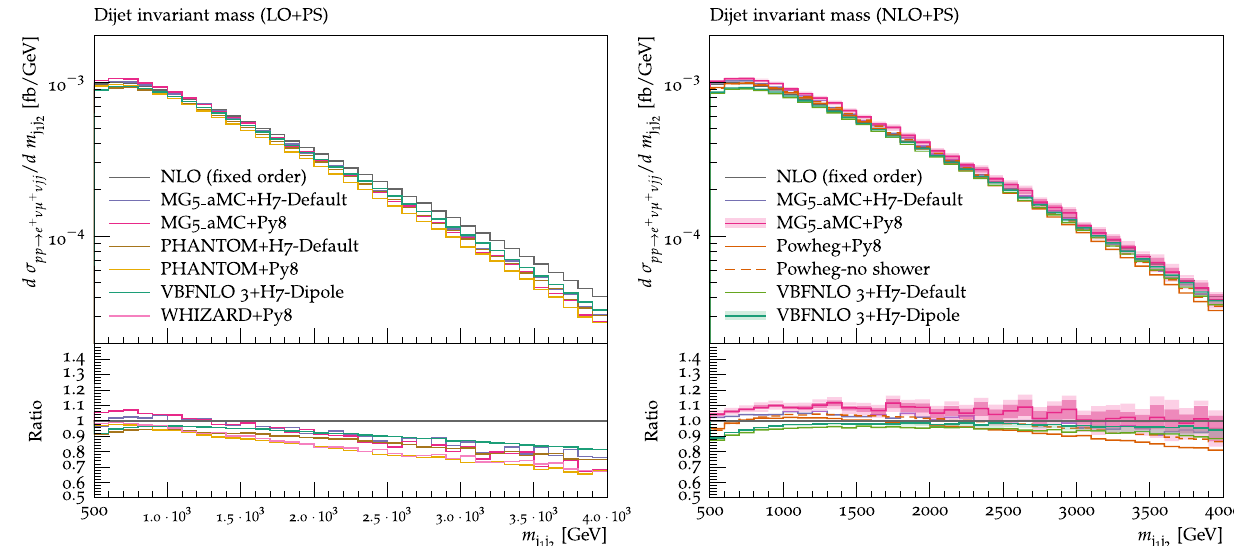
Fig. 14 Differential distribution in the invariant mass of the two tag- ging jets from predictions matched to parton showers, at LO (left) or NLO (right) accuracy (upper plot), compared with the fixed-NLO result computed with VBFNLO (lower plot). At NLO+PS accuracy, for VBFNLO + Herwig7- Dipole , the three-point scale uncertainties are